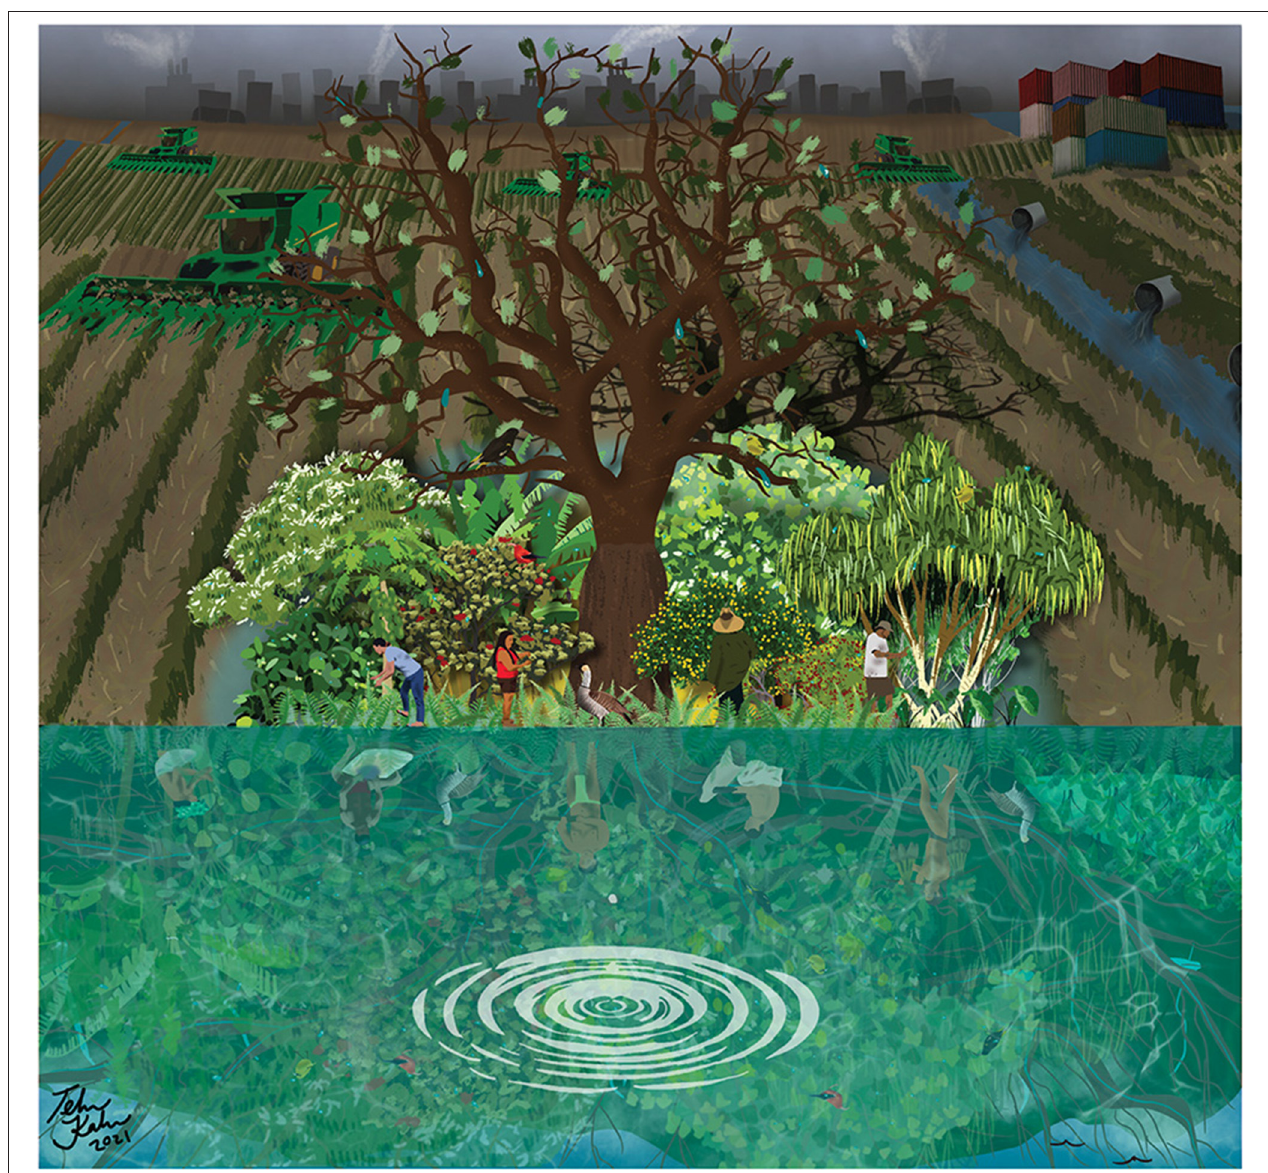
FIGURE 3 | Practitioners’ values and resulting agroforestry practices, based in relationships and reciprocity, conflict with dominant institutions and systems of resource access in Hawai‘i that value short-term production and economic profit. These contested values and an imbalance in power between practitioners and landowners, government agencies, policymakers, and other institutions cause agroforestry practitioners to fall through the cracks. This illustration depicts how the conflict of values and power is like a tree whose top has been cut off and a new top grafted on, but the two trees (value systems) are incompatible, so the grafted tree struggles to survive and never produces fruit. Many Indigenous and local practices of agroforestry (area below the graft wound) are rooted in ancestral knowledge (roots and reflection below ground) and are impeded by the values of the dominant regime (grafted top). Some Indigenous and local practitioners are able to circumvent obstacles (push past the graft wound), yet structural change is needed to create more equitable access to participation and enable more just agroforestry transitions. Artwork by Tehina